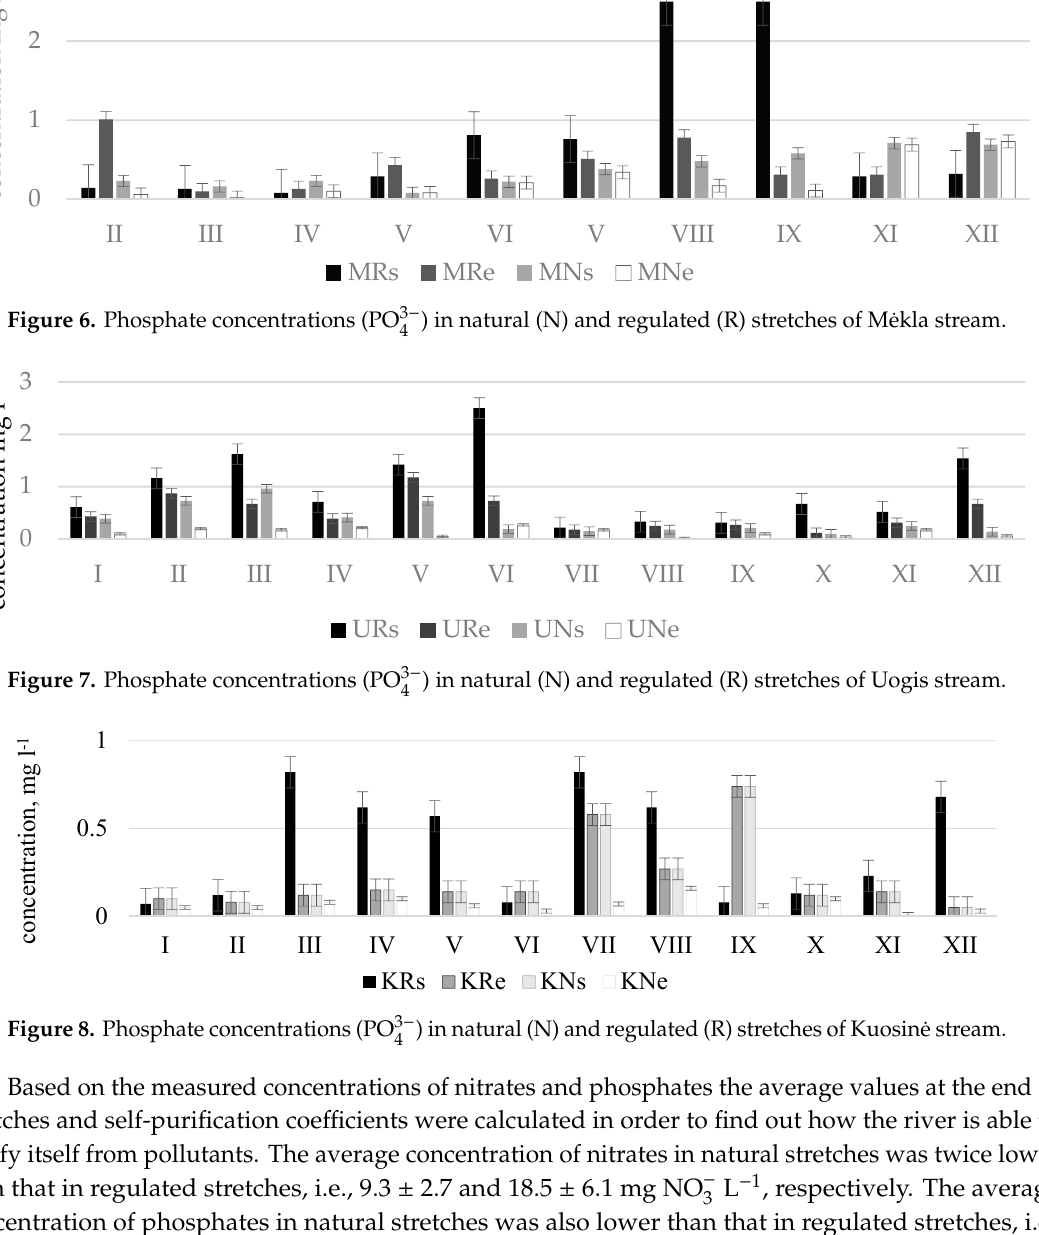
Figure 6. Phosphate concentrations ( PO (cid:2872)(cid:2871)(cid:2879) ) in natural (N) and regulated (R) stretches of M ė kla stream.